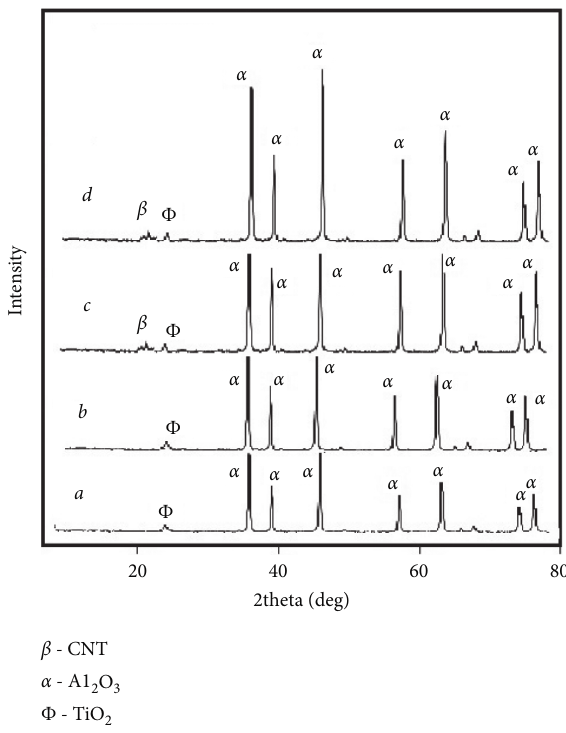
Figure 4: XRD pattern of (a) Al 2 O 3 +3wt%TiO 2 coating without CNTs reinforcement, (b) Al 2 O 3 +3wt%TiO 2 +1% CNTs reinforced coating, (c) Al 2 O 3 + 3wt%TiO 2 + 3% CNTs reinforced coating, and (d) Al 2 O 3 +3wt%TiO 2 +5% CNTs reinforced